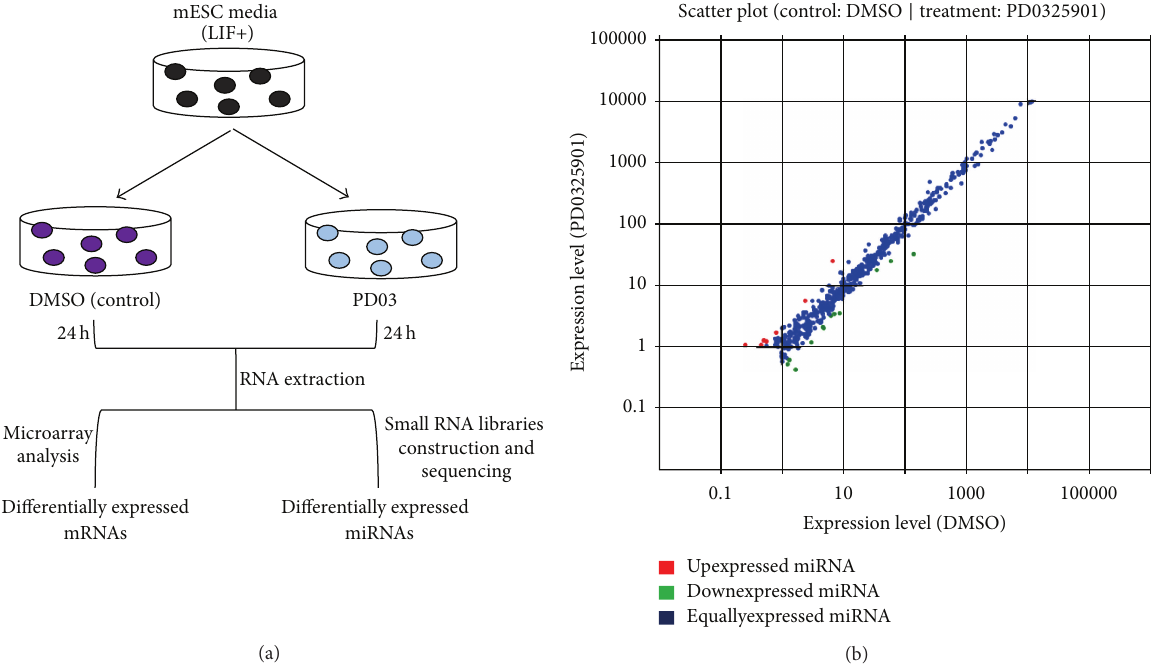
Figure 3: Experimental scheme for sample preparation of small RNA deep-sequencing and microarray analysis. (a) Experimental scheme for small RNA deep-sequencing and microarray analysis. J1 mESCs cultured in LIF containing media were treated with 1 𝜇 M PD or equal volume ofDMSO(control)for24h,andthenthetotalRNAswereextractedandqualifiedRNAswereanalyzedbymicroarraygeneexpressionprofiling and small RNA deep-sequencing to identify differentially expressed mRNAs and miRNAs. (b) Comparison of the known miRNA expression between DMSO- and PD-treated samples. The scatter plots show the distribution of the detected miRNAs with or without 1 𝜇 M PD treatment in mESC medium for 24 h. Significant regulated miRNAs with 1.5-fold change are marked red (upregulated) and green